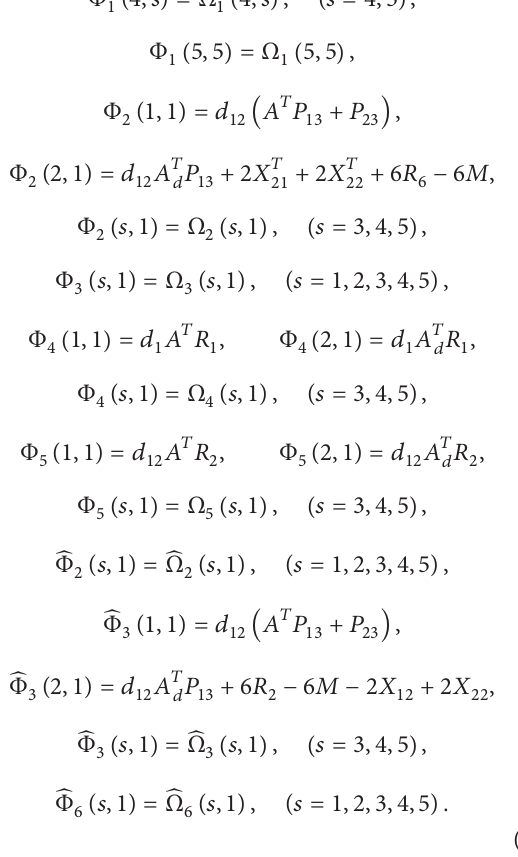
Table 1: Admissible upper bounds 𝑑 2 with varying 𝑑 1